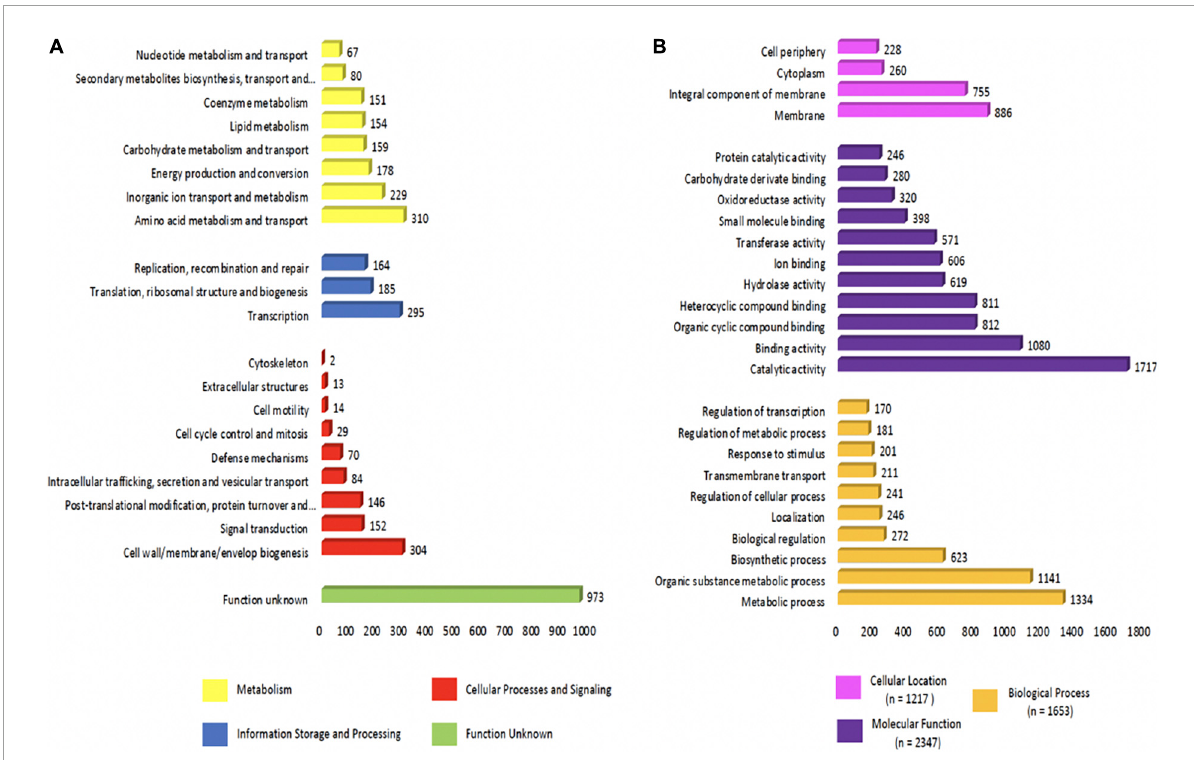
FIGURE2 Functional annotations of Chryseobacterium indologenes strain. ( A ) Clusters of orthologous groups (COGs) based on functional annotation using eggNOG-mapper. ( B ) Distribution of gene ontology